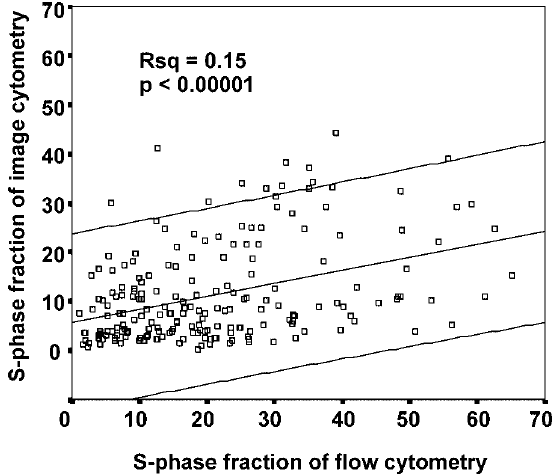
Fig. 2. Urothelial cell carcinomas (UCs). Scatterplot of DNA index (DI) and S phase fraction (SPF) by flow cytometry (FCM) in 202 cases. Note the high values of SPF. Closed triangle; grade 1, open circle, grade 2; closed square, grade 3. This figure can be viewed on